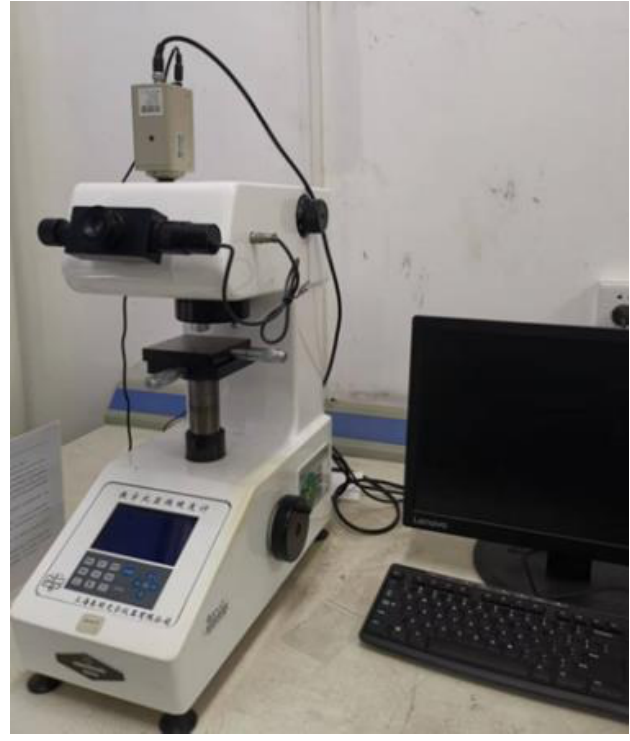
Figure 4. The Vickers hardness tester.